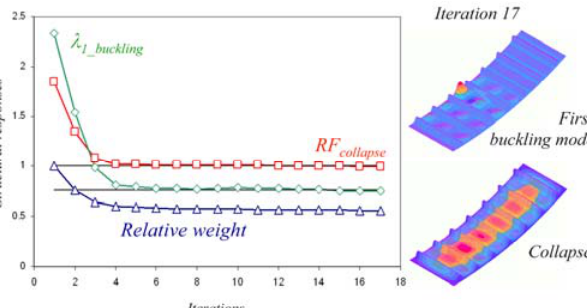
Fig. 10. Convergence history for buckling and collapse opti- mization